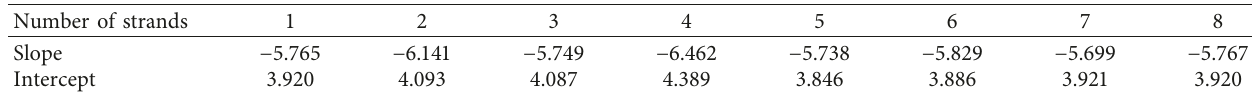
Table 3: The parameters of the fitted